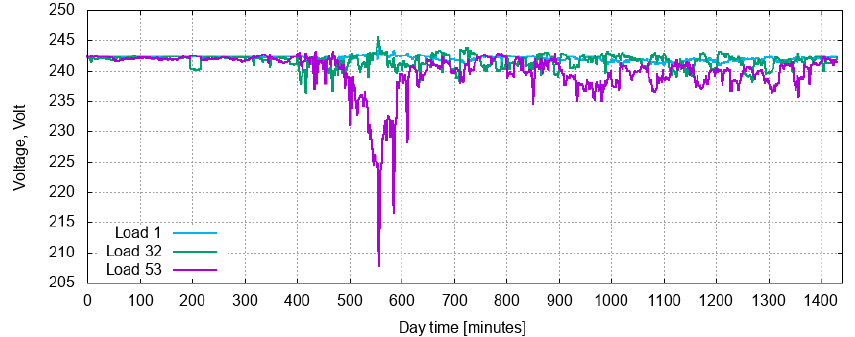
Figure 4. Attack scenario 2—Voltage levels under attack.